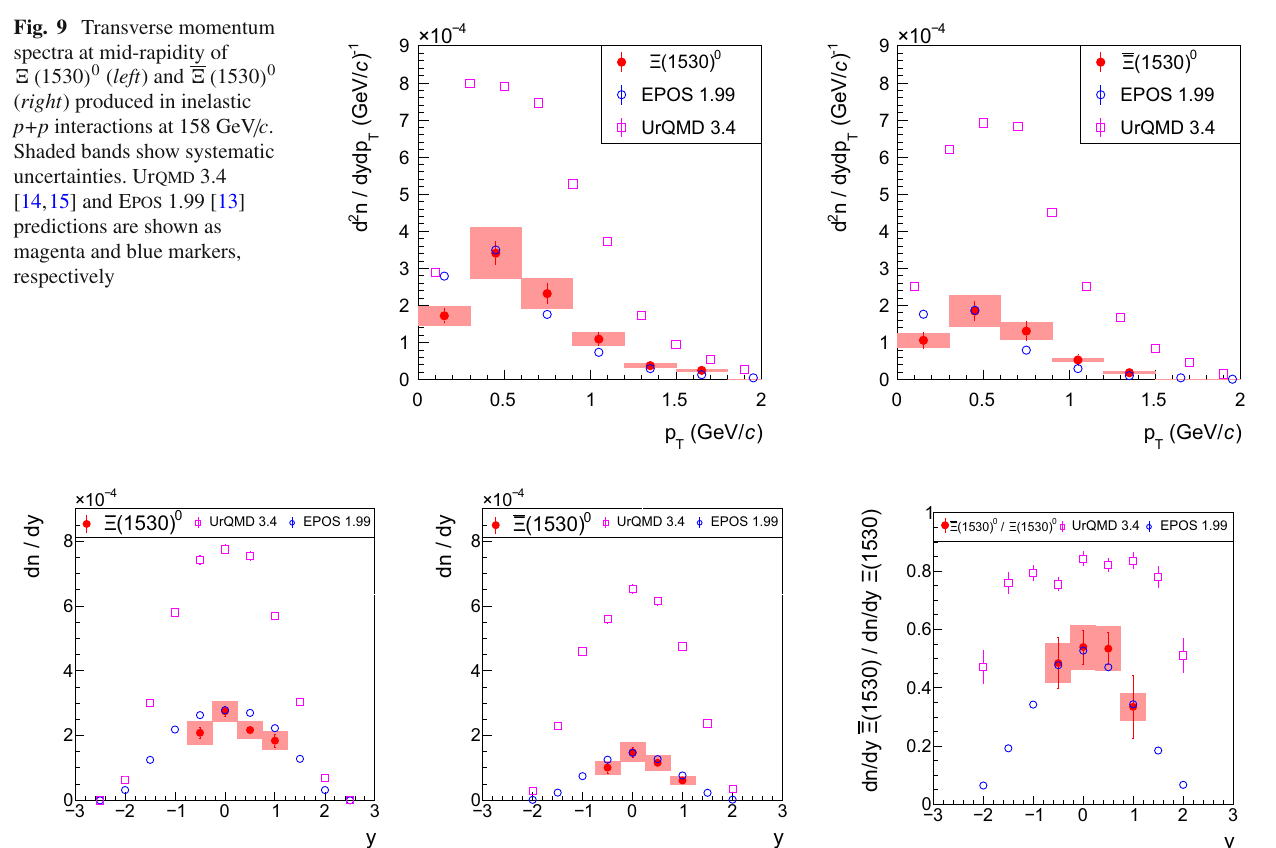
Fig. 9 Transverse momentum spectra at mid-rapidity of (cid:2)( 1530 ) 0 ( left ) and (cid:2)( 1530 ) 0 ( right ) produced in inelastic p+p interactions at 158 GeV / c . Shaded bands show systematic uncertainties. U r qmd 3.4 [14,15] and Epos 1.99 [13] predictions are shown as magenta and blue markers,